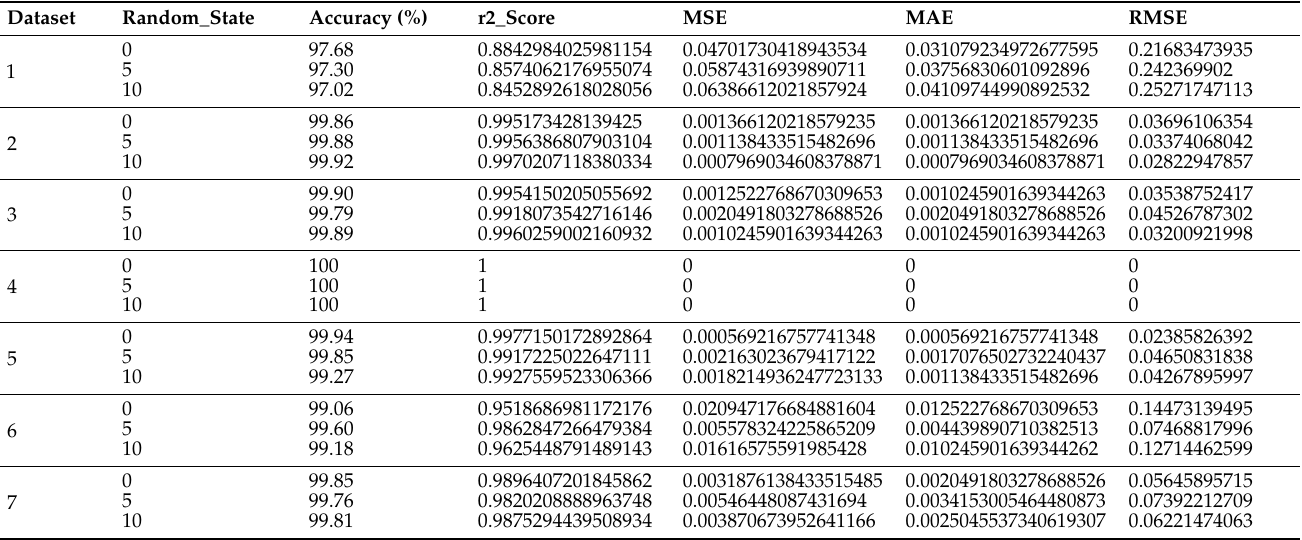
Table 6. Impact of random_state on the performance of the random forest with n_estimators =